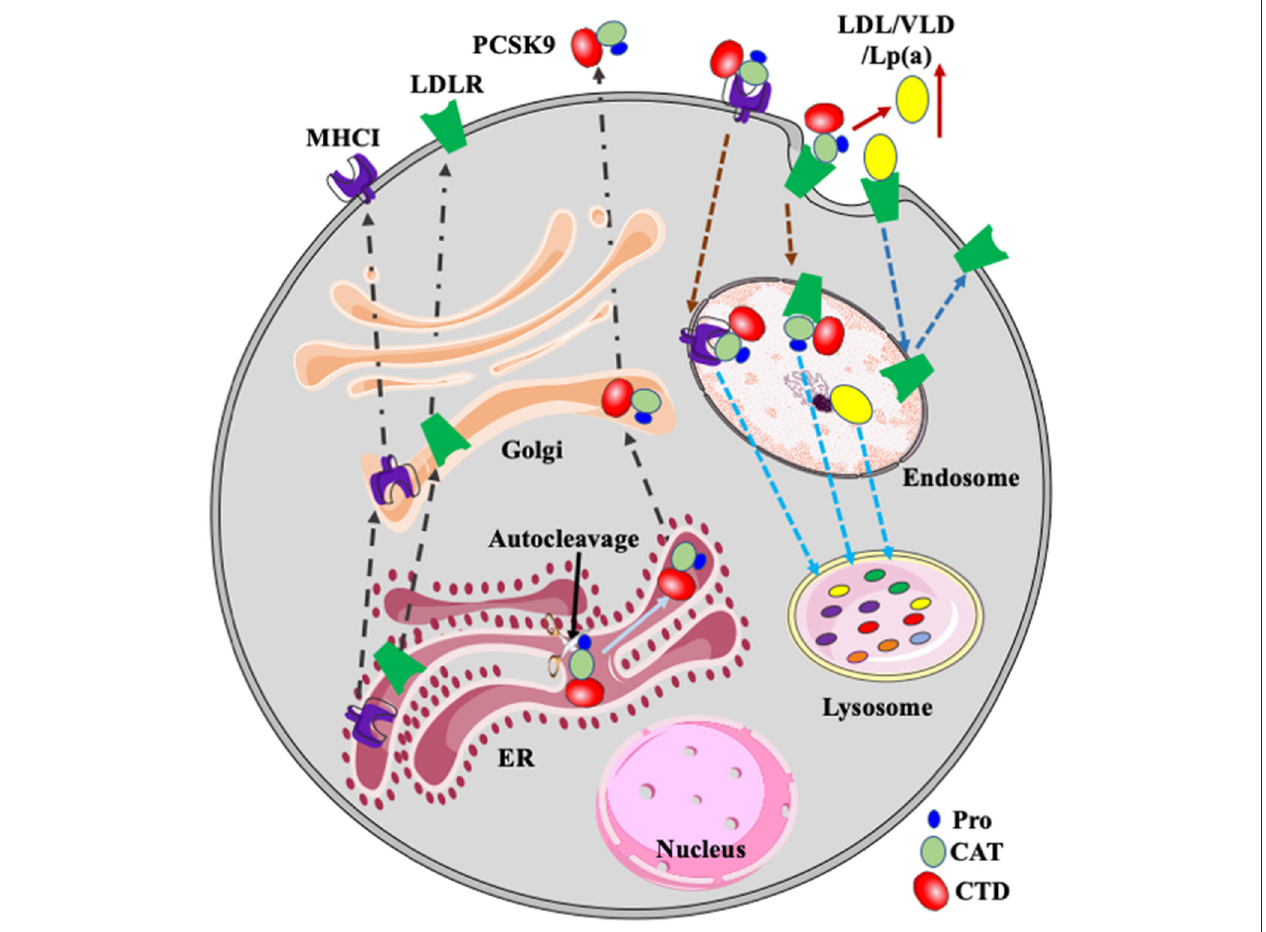
FIGURE 1 | PCSK9, LDLR, and MHCI. PCSK9 is auto-cleaved in the ER. Mature PCSK9 is transported to the Golgi and then secreted. PCSK9 binds to LDLR and MHCI on the cell surface. After, the complex is delivered to endosomes via endocytosis and then transported to the lysosome for degradation. LDLR binds to its ligands such as LDL, VLDL, and Lp(a) and then the receptor/ligand complex enters cells via receptor-mediated endocytosis and is delivered to the endosome. In the acidic endosomal environment, the ligand, such as LDL, is released from LDLR and transported to the lysosome for degradation. LDLR is recycled to plasma membrane. PCSK9-promoted degradation of LDLR increases plasma levels of LDL and Lp(a). Pro, prodomain; CAT, catalytic domain; CTD, C-terminal domain.